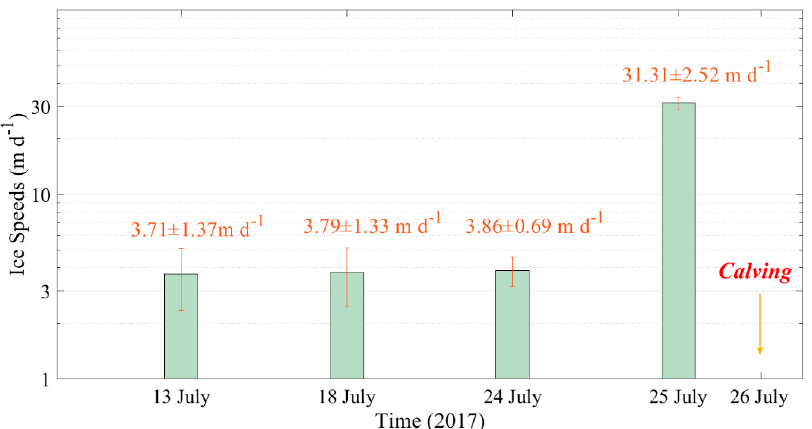
Figure 4. The time series of Petermann Glacier’s velocit y , the blue polygon in Fig ure 3, during July 2017, prior to the calving event. Additionally, the red error bar represents the velocity accuracy evaluation.